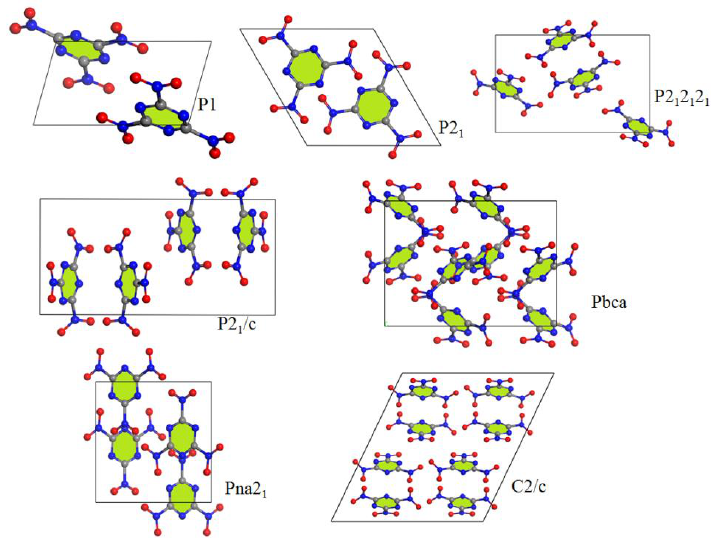
Figure 2. Most stable structures of TNTA for 7 different space groups obtained using Monte Carlo simulated annealing and Dreiding FF optimization. Table 2. Unit cell parameters of the possible molecular packing of